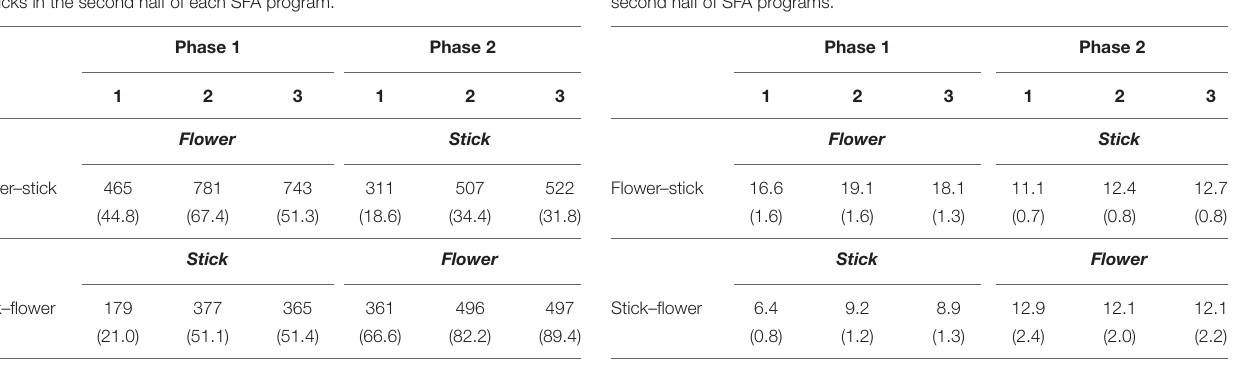
TABLE 3 | Mean performance times (s) for creating one arrangement with flowers or sticks in the second half of each SFA program.